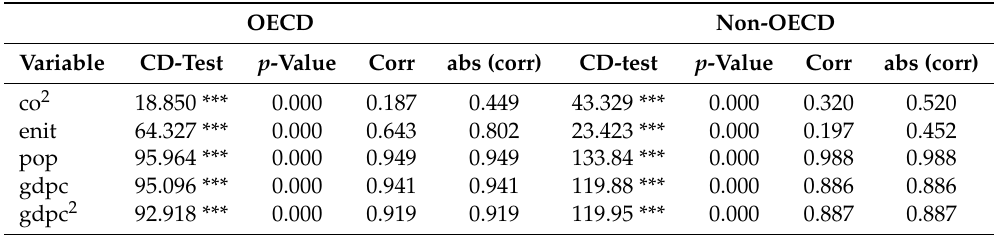
Table 1. Pesaran (2004)’s test for cross-section correlation of the errors in the augmented Dickey–Fuller, ADF(p), regression. OECD Non-OECD